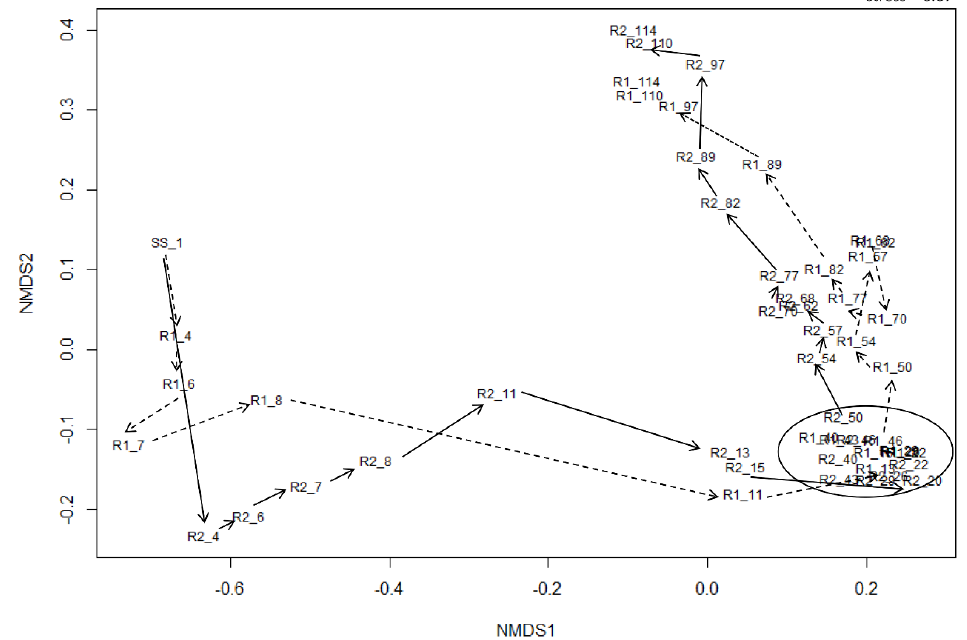
Figure 5. Non-metric multidimensional scaling (NMDS) ordination based on the T-RFLP dataset. Samples are indicated with the identifier of the reactor (R1 or R2) and the number of days since start-up. SS = seed sludge. The black circle marks the period when the community composition was relatively unchanged (after start-up but before the resumption of sampling). Water 2016 , 8 , 172